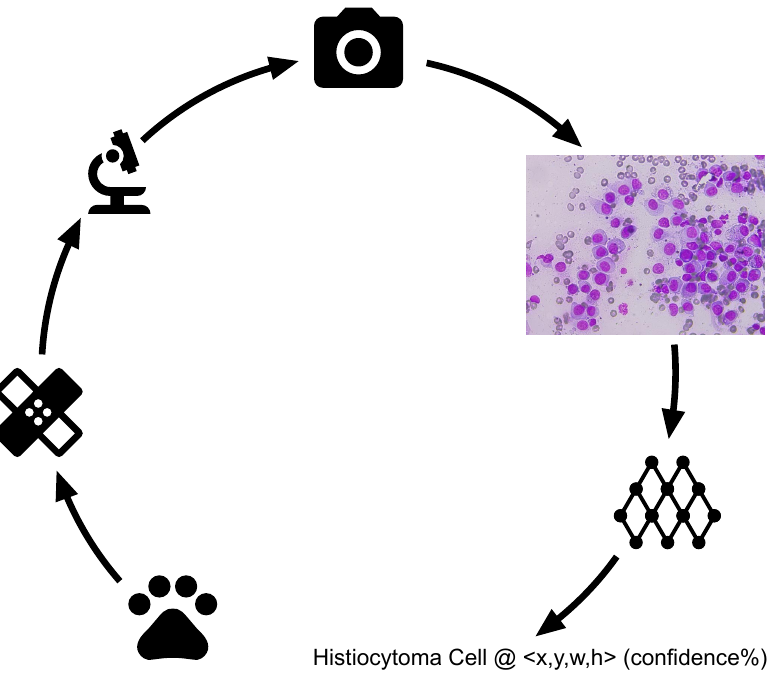
Figure 1. The basic stages of the experiment: obtaining the data, training the model, and getting the result. Graphic uses https://material.io/resources/icons (accessed on 10 March